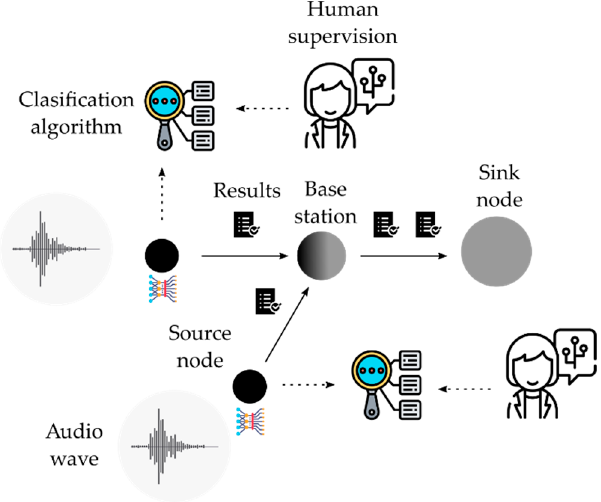
Figure 6. Decentralized architecture.